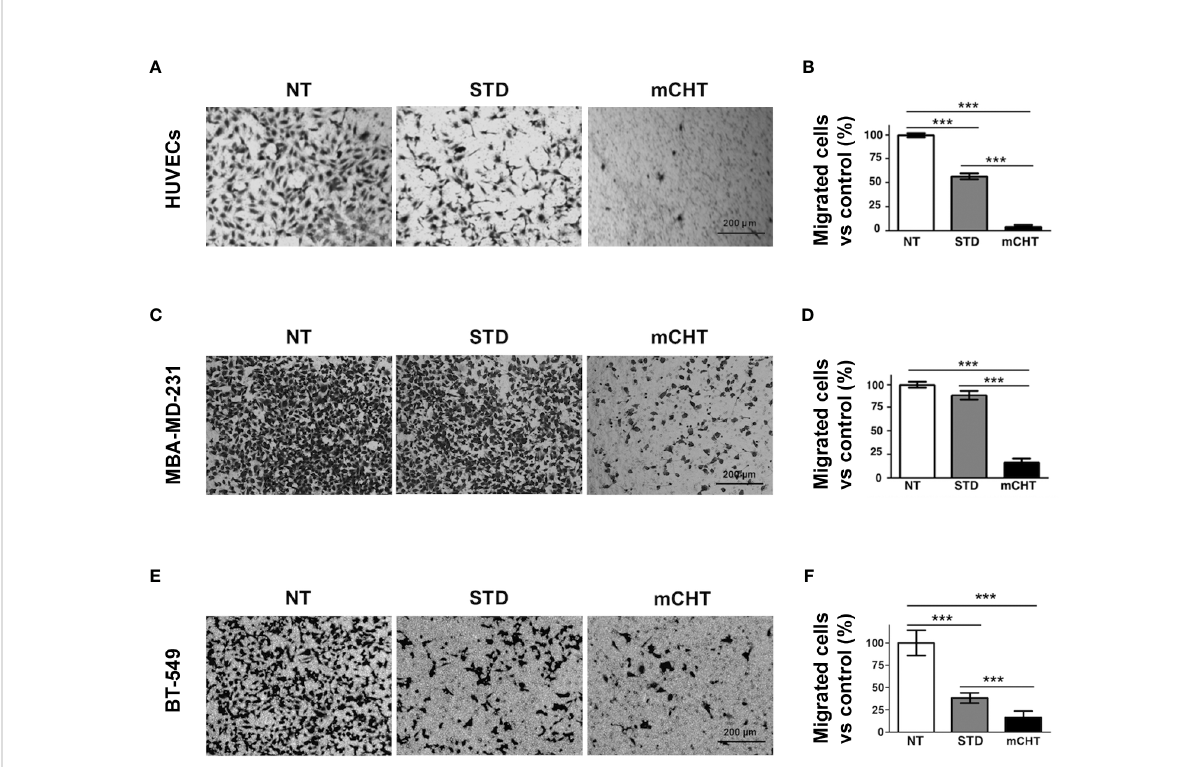
FIGURE 4 Metronomic treatment with 5-FU+VNR suppresses HUVECs and TNBC cell migration more ef fi ciently than standard administration. Representative images of the Transwell assays on HUVECs (A) , MDA-MB-231 cells (C) and BT-549 (E) treated for 96h under the STD or mCHT protocol and performed as described in Material and Methods. Migrated cells were stained with crystal violet, counted, and graphically expressed as a percentage of the untreated control (B, D, F) .Values represent the average ± SD of three independent experiments. **p < 0.01; ***p <